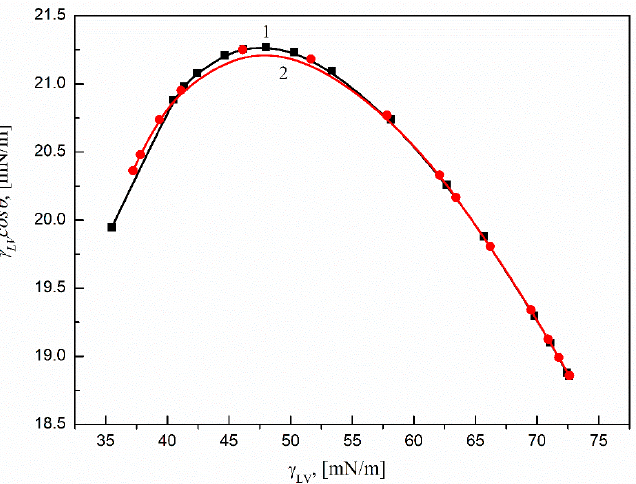
Figure 6. A plot of the adhesion tension ( γ LV cos) of the aqueous solutions of SMD (curve 1) and SML (curve 2) vs. the solution surface tension γ LV